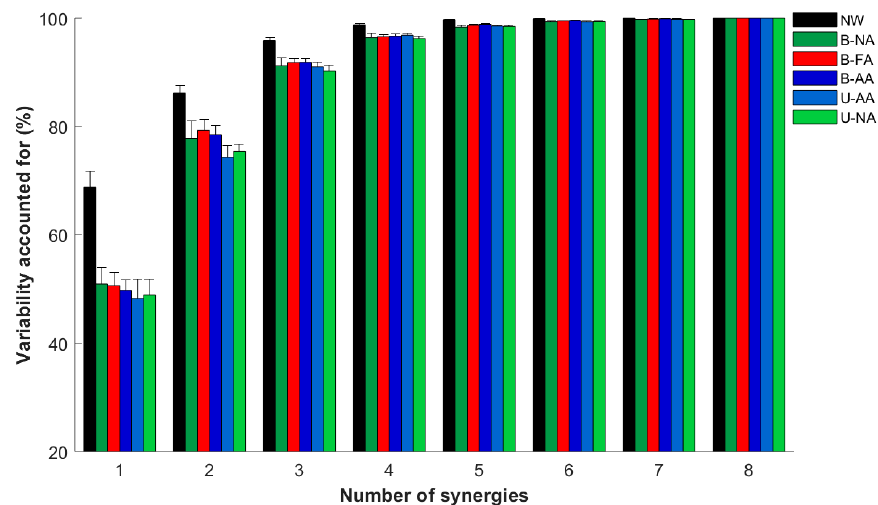
Figure 7. Total variability accounted for (mean ± se) based on the number of modules extracted by non-negative matrix factorization (NNMF) for all the investigated walking conditions (normal walking without the Ekso: NW; Ekso-assisted walking: B-NA, B-FA, B-AA, U-AA, U-NA). Colors indicate the different walking modalities: black for normal walking without the Ekso (NW); the other colors refer to walking with the Ekso with bilateral no assistance (B-NA, dark green), bilateral full assistance (B-FA, red), bilateral adaptive assistance (B-AA, dark blue), unilateral adaptive assistance (U-AA, light blue), and unilateral no assistance (U-NA, light green).